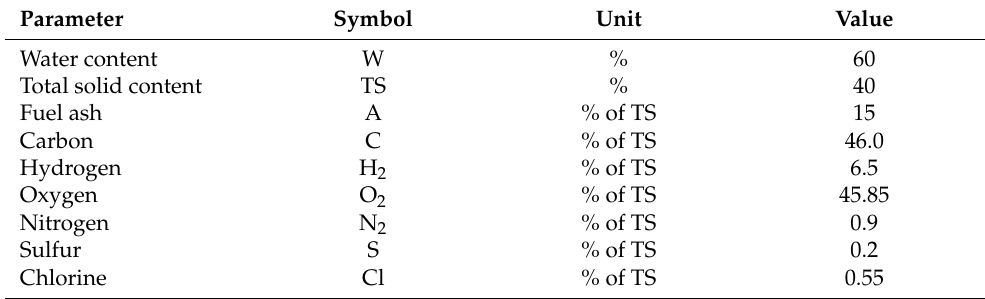
Table 1. Elementary analyses of the composition of raw waste collected in Jordan